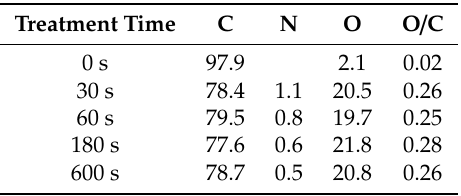
Table 2. XPS surface composition of PS exposed directly to Ar APPJ at various treatment